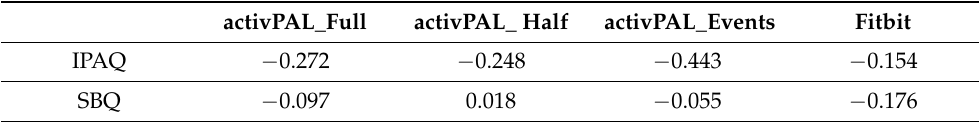
Table 2. Correlation between minutes of self-reported and objectively measured sedentary